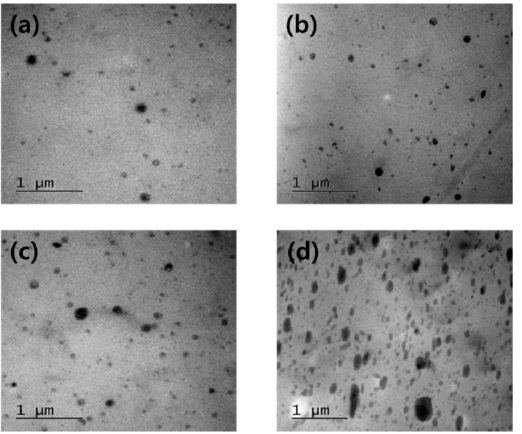
Figure 1. FE-TEM images of mPOE/PANI blends with ( a ) 3, ( b ) 5, ( c ) 10, and ( d ) 15 wt.% of PANI content (magnification ×50.0k).